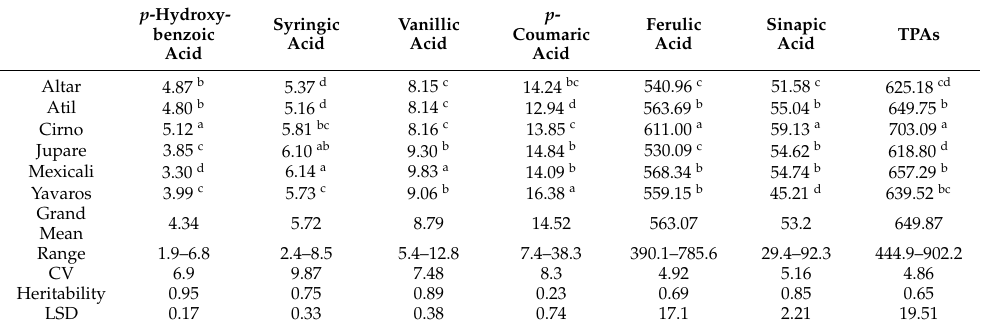
Table 1. Mean values, minimum/maximum values, coefficient of variation (CV), heritability and least significant difference (LSD) for grain phenolic acids content ( µ g/g dry matter) in six CIMMYT durum wheat cultivars evaluated across two years and six growth conditions. TPAs: total sum of individual phenolic acids. Numbers with the same letter in each column are not significantly different ( p <